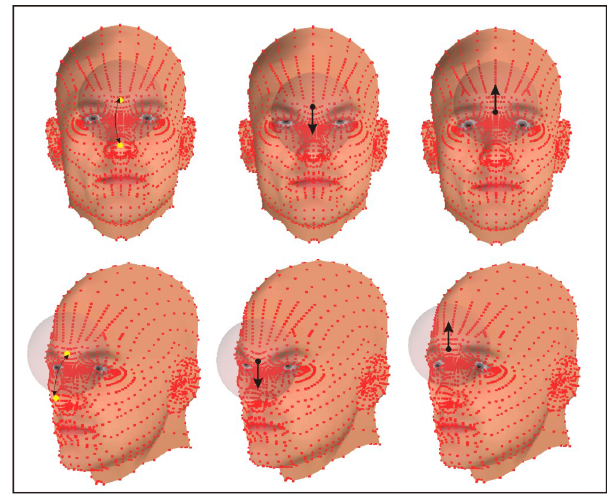
Figure 11. Generation of facial expressions by spherical influence